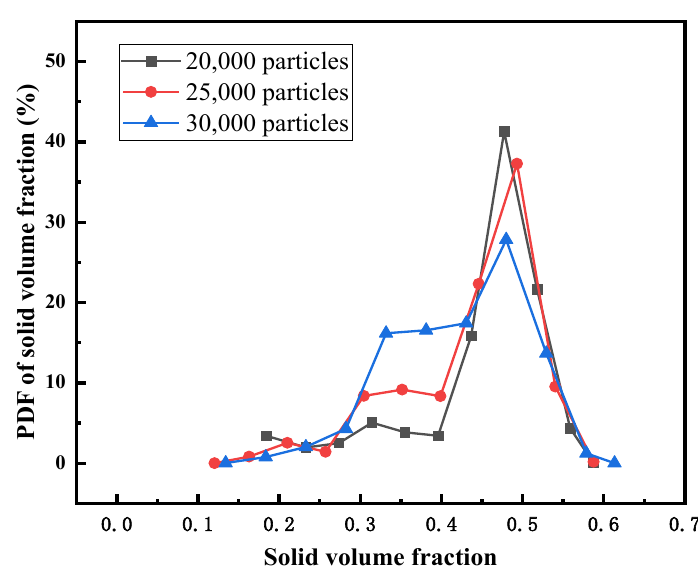
Figure 7. PDF of the solid volume fraction for different initial bed heights.